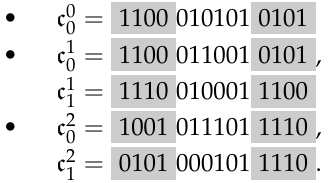
are different from the four bits on the right of c 1 0 and c 1 . The four bits on the left side 0 1 , so c 1 is added to the candidate RE 1 1 are the same as the four bits on the left side of c 1 0 are not equal to the four bits on the right side of c 0 0 and c 1 . In C 2, not only are the four bits on the 0 1 , but also the four bits on the 1